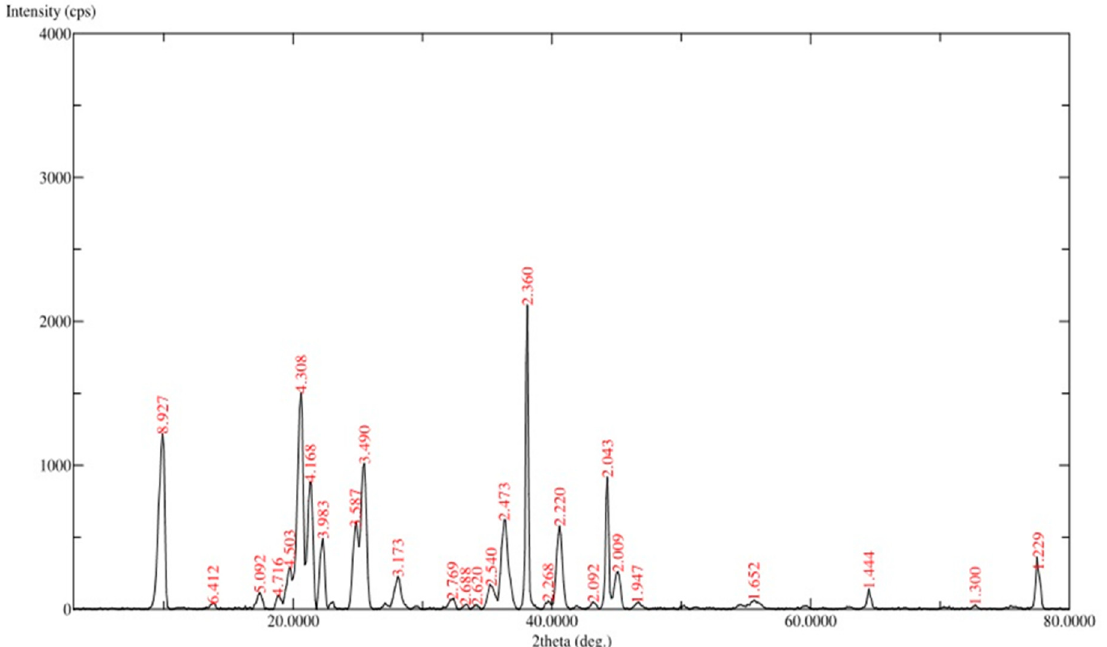
Figure 4. XRD analysis of lyophilized recombinant HBsAg-loaded docosahexaenoic acid nanovesi- cles